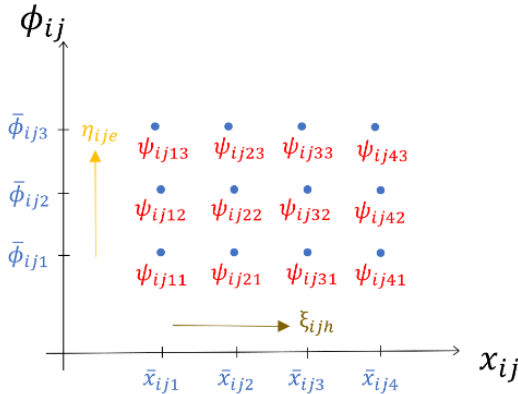
Figure 5. Grids defined for piecewise linearisation of the BPR function.